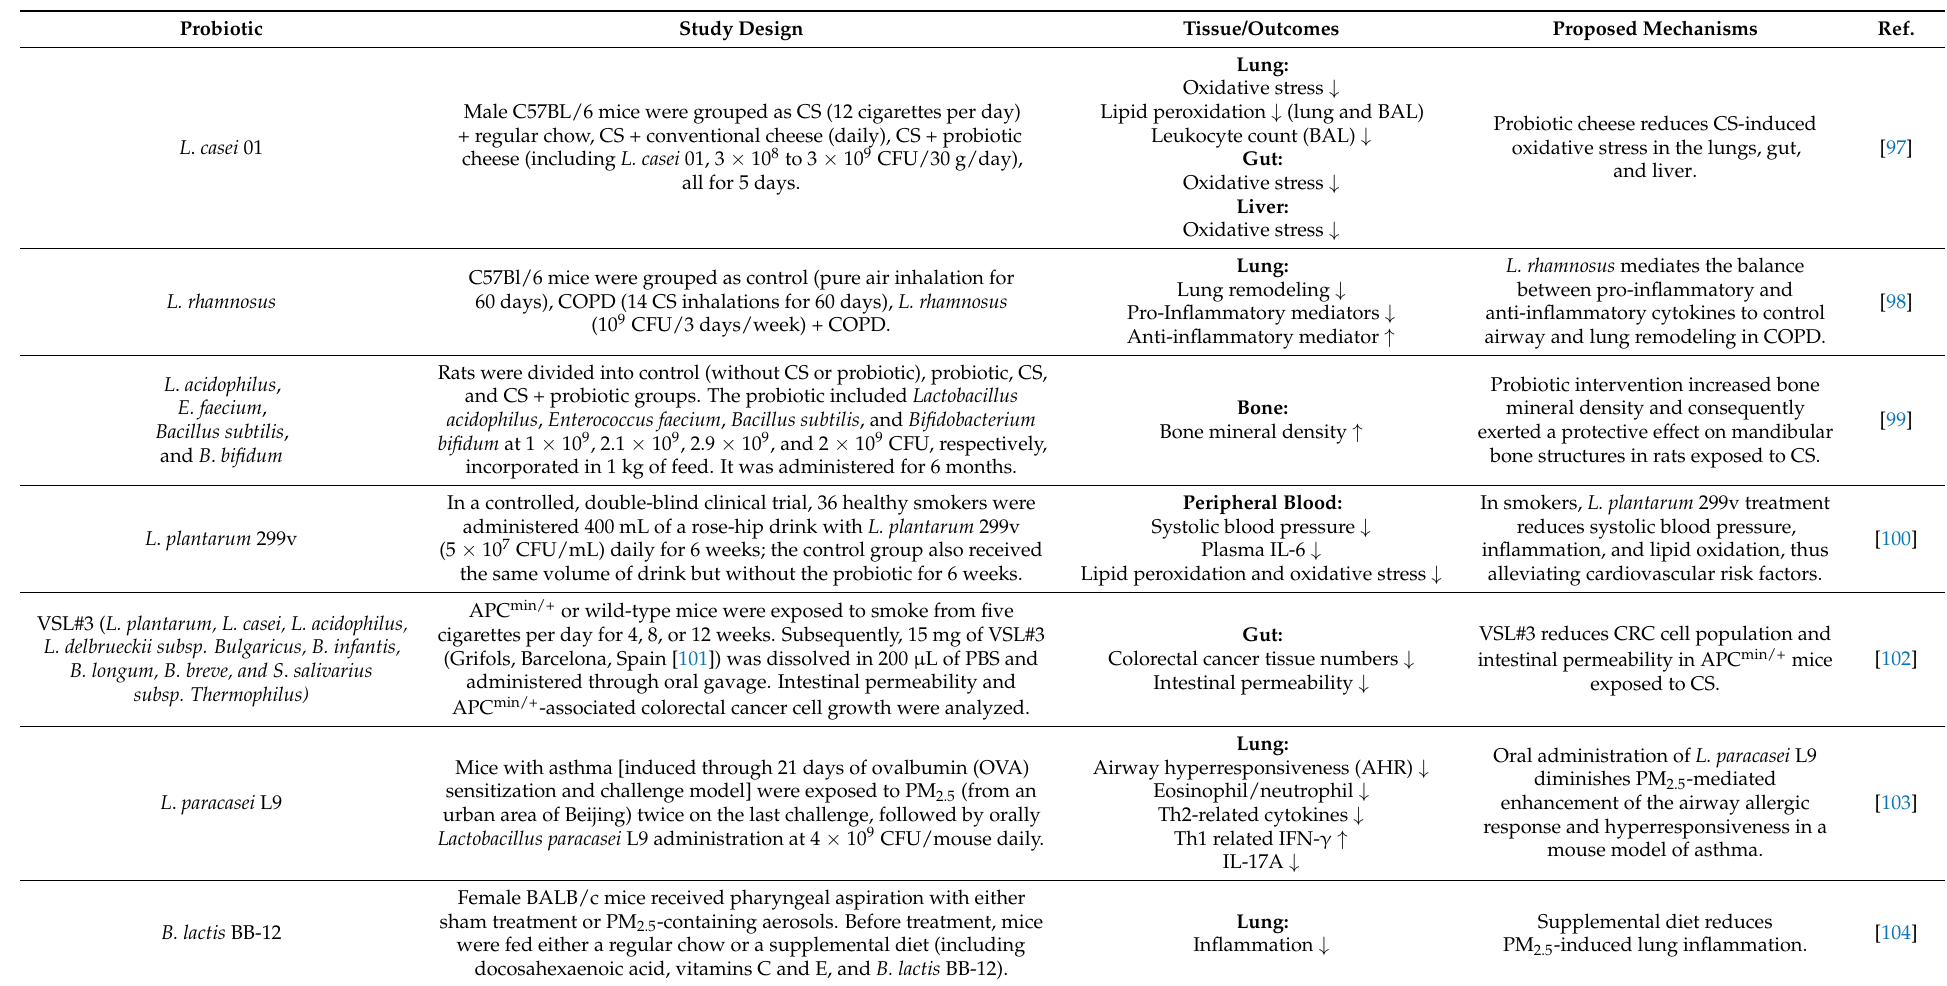
Table 1. Therapeutic effects of probiotics on CS- and PM-mediated inflammation and metabolic